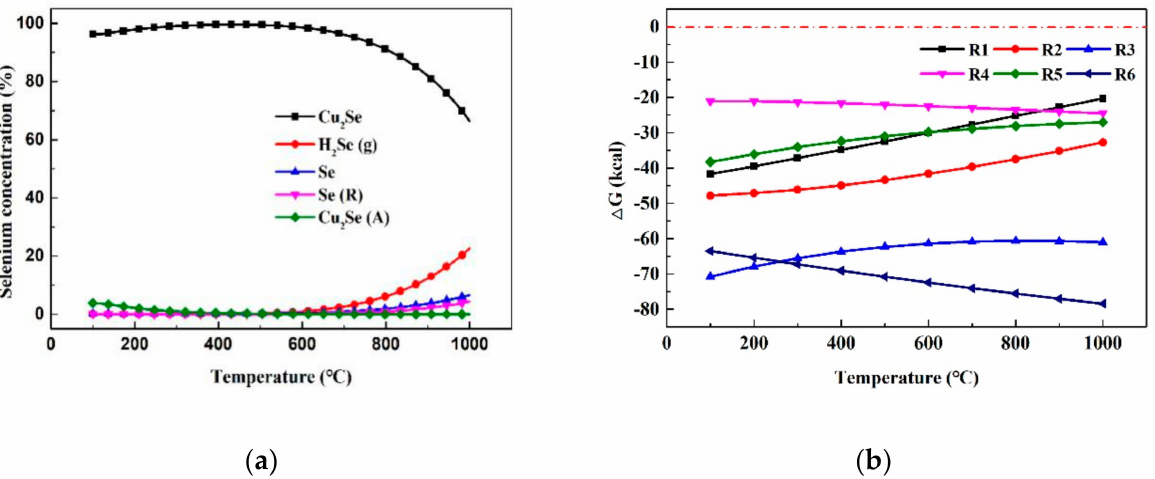
Figure 5. ( a ) The existing form of selenium in CLG; ( b ) Gibbs free energy with temperature for reactions ((R1)–(R6)).